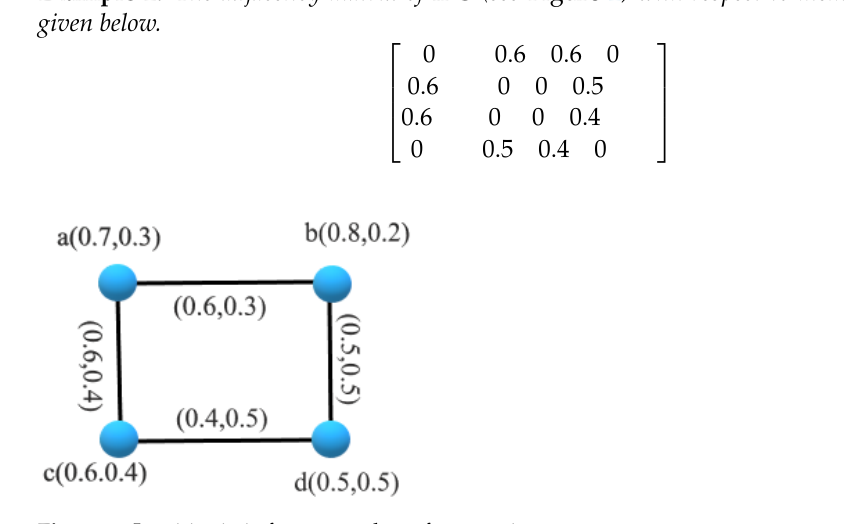
Figure 2. Intuitionistic fuzzy graph on four vertices.. Algorithm 1: Algorithm to find the 1st component of the strength of connectedness between pair of vertices in the form of an adjacency matrix of an IFG Input: A weighted undirected Graph value of an IFG membership weight[w(x,y)] of IFG.